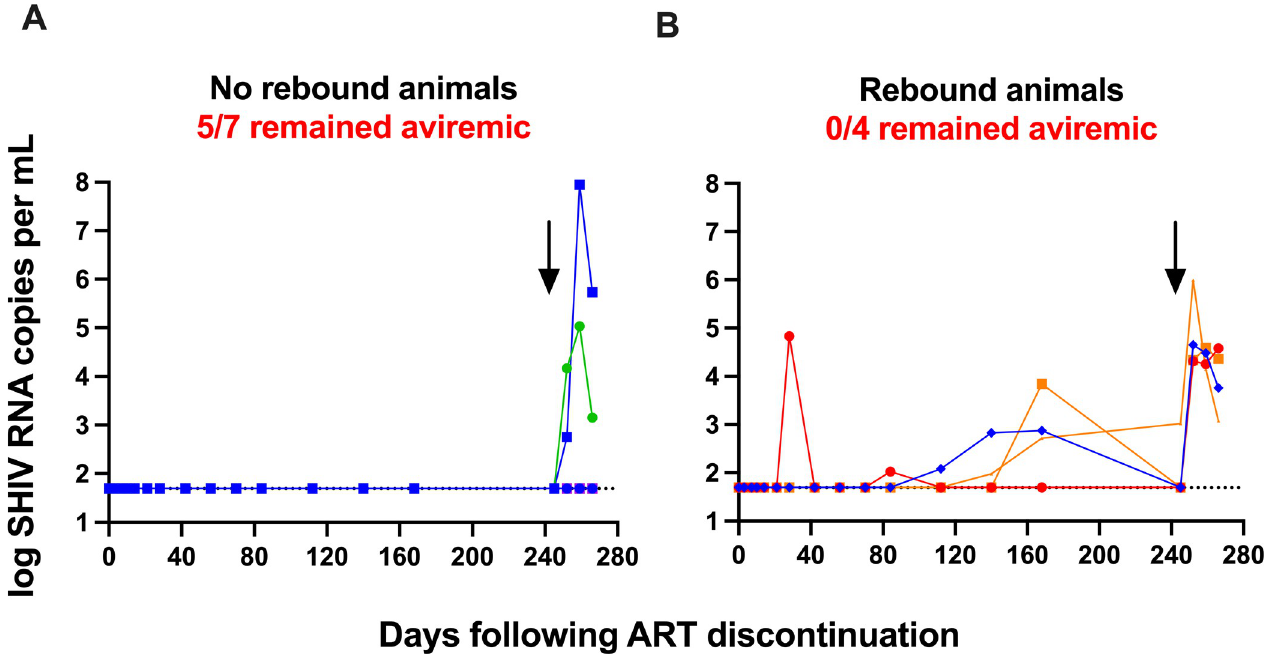
Fig 7. CD8+ cell depletion. Plasma viral loads before and after CD8+ cell depletion in (A) animals with no viral rebound (n = 7) and (B) animals with viral rebound (n = 4) following ART discontinuation. Numbers of animals that remained aviremic and total number of animals are shown. Arrows indicate CD8 + cell depletion on day 245 (week 77) after ART discontinuation. Dotted lines indicate limit of detection, values on the line were below limit of detection. Individual symbol and color coding as indicated in S1 Table.